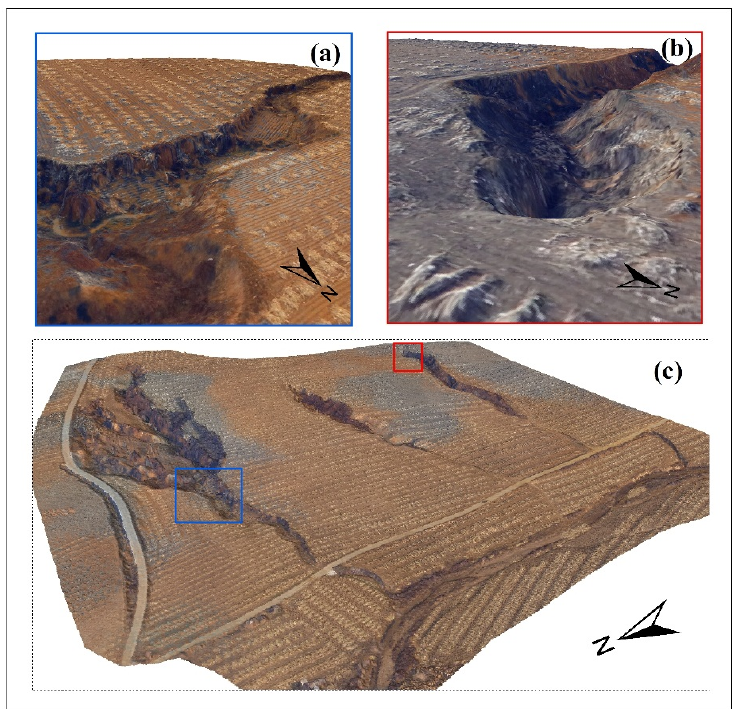
Figure 5. (a– c ). 3D model of the small study site ( c ). The blue ( a ); and red ( b ) enlarged insets show the 3D structure of the gully sidewall and headcut in detail, respectively.